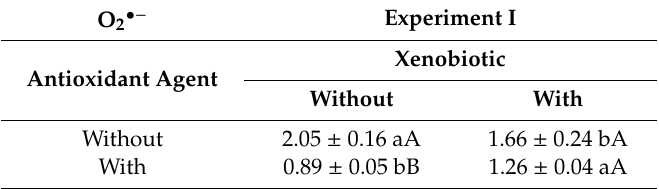
Table 8. Superoxide (mmol protein − 1 min − 1 ) in soybean plants submitted to xenobiotic and antioxidant agent Table 9. Superoxide (mmol protein − 1 min − 1 ) in soybean plants submitted to different soil water potentials and xenobiotic and antioxidant agent applications.